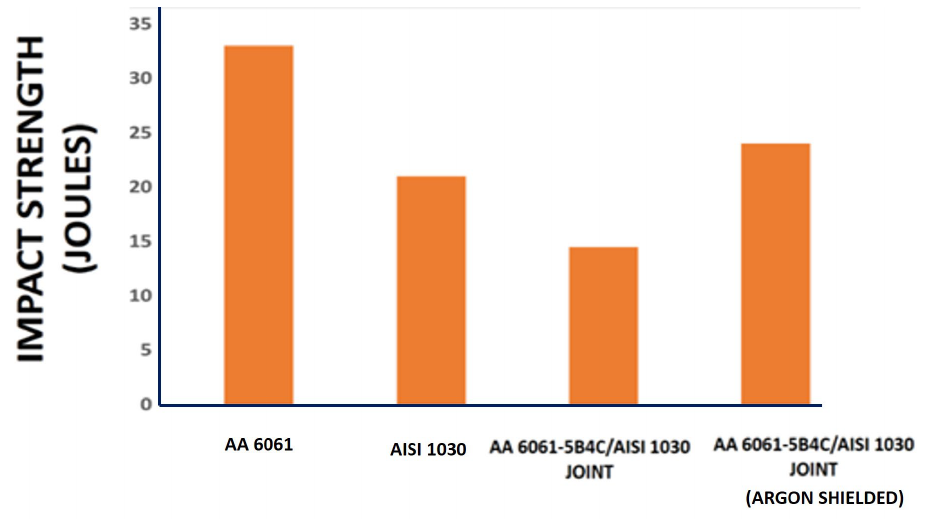
Figure 18. Comparison of impact strength of friction welded joints.